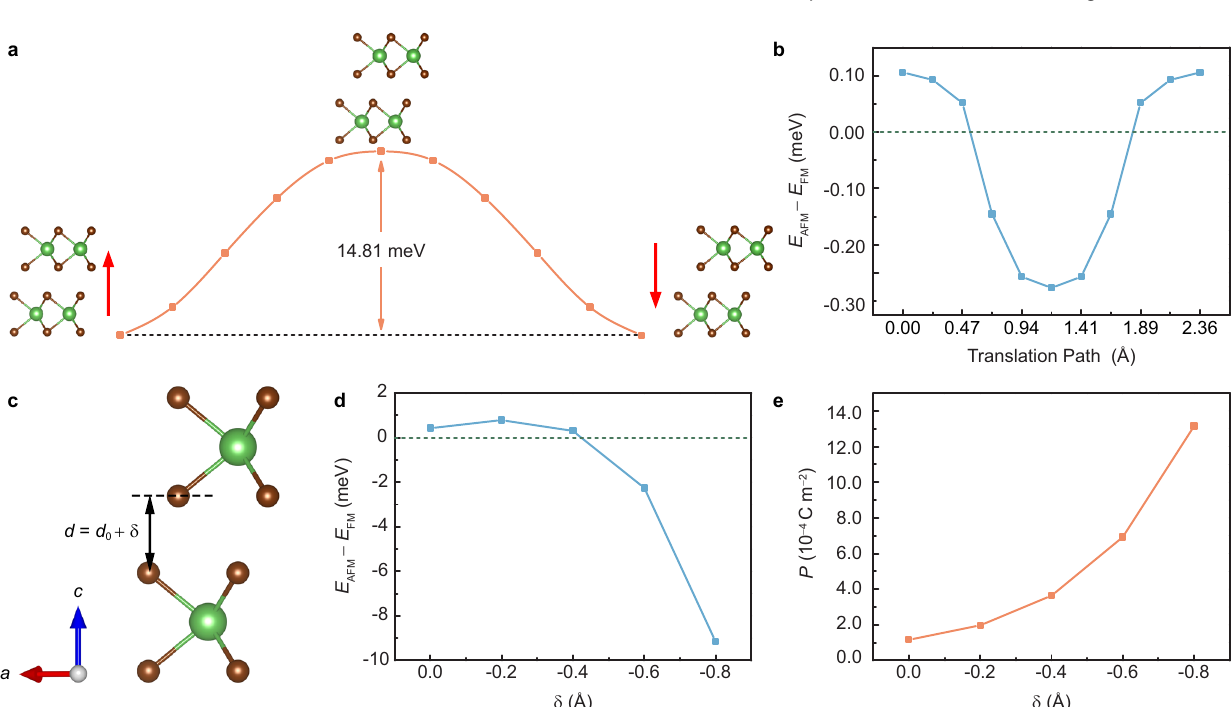
Fig. 2 Ferroelectricity and magnetism of 3 R LaBr 2 bilayer. a FE switching pathway of 3 R LaBr 2 bilayer, the red arrows denote the polarization direction. b Total energy difference between AFM and FM in FE switching pathway. c de fi nes the distance d between two LaBr 2 layers. d , e Energy difference ( E AFM - E FM ) and polarization ( P ) are as a function of δ ,